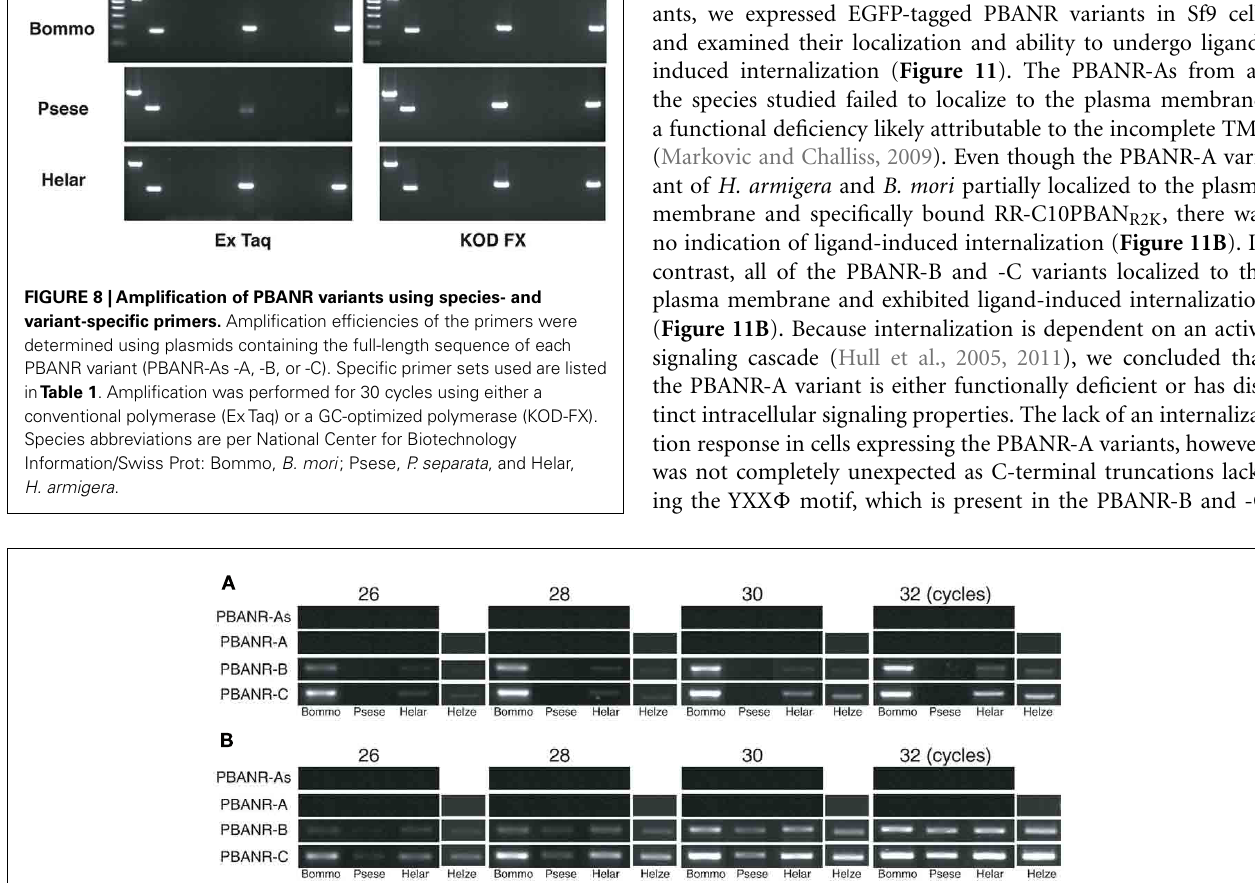
FIGURE 9 | RT-PCR analysis of PG-derived PBANR variants. RT-PCR was performed using B. mori , P . separata , H. armigera , and H. zea PG cDNAs with either (A) a conventional DNA polymerase (ExTaq) or (B) a GC-optimized DNA polymerase (KOD-FX). Amplifications were performed using 26–32 PCR cycles as